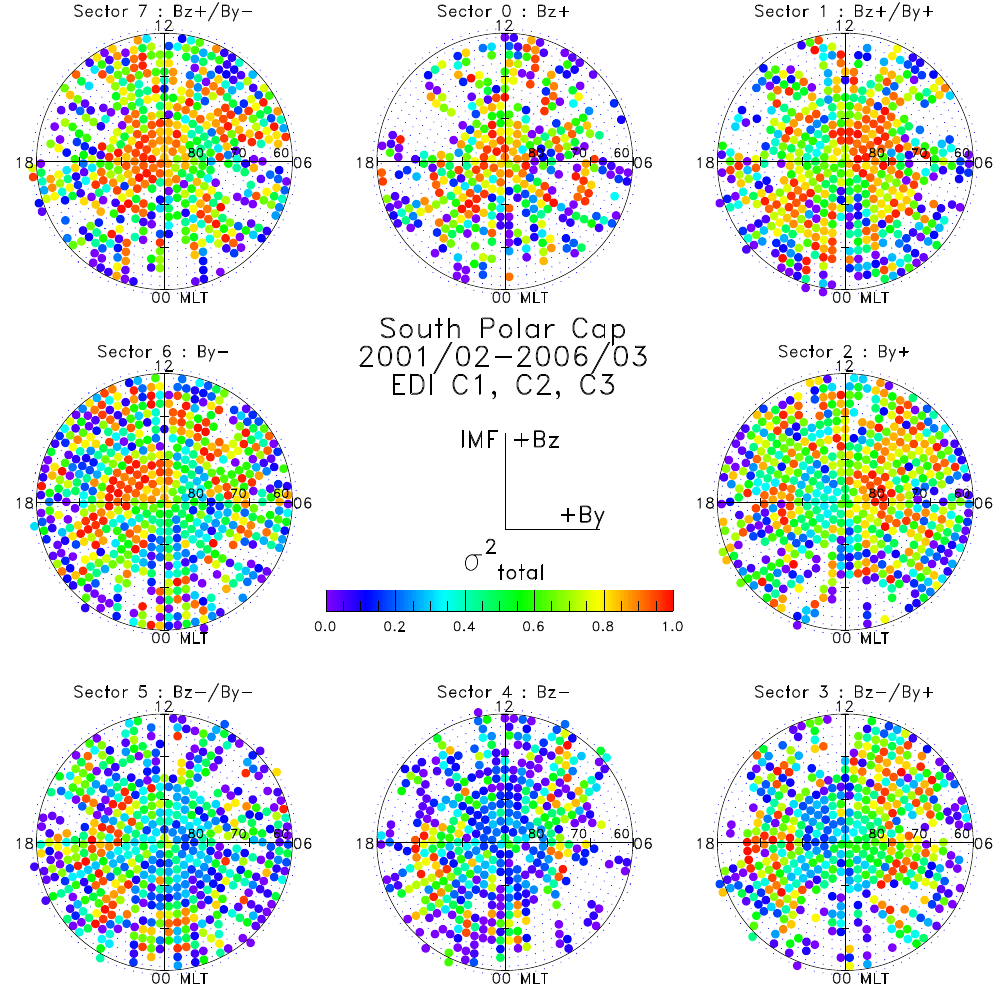
Fig. 4. As in Fig. 3, but for the Southern Hemisphere.